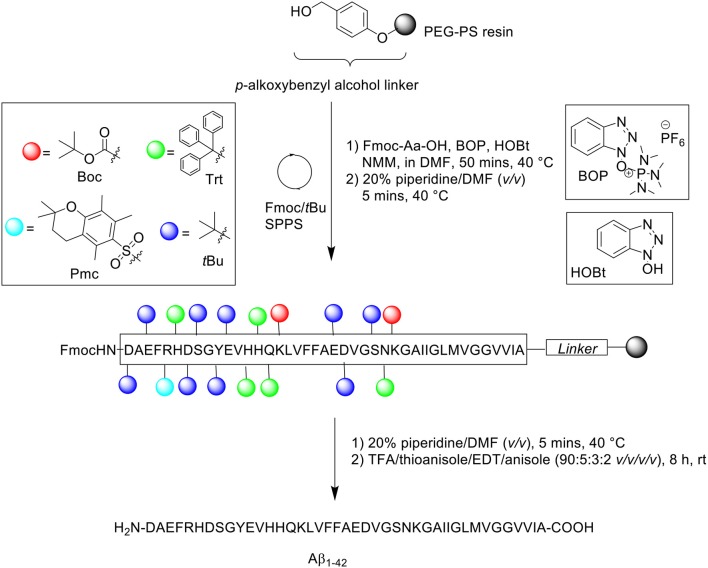
Fmoc/tBu SPPS of Aβ1−42 by Burdick et al. (1992).